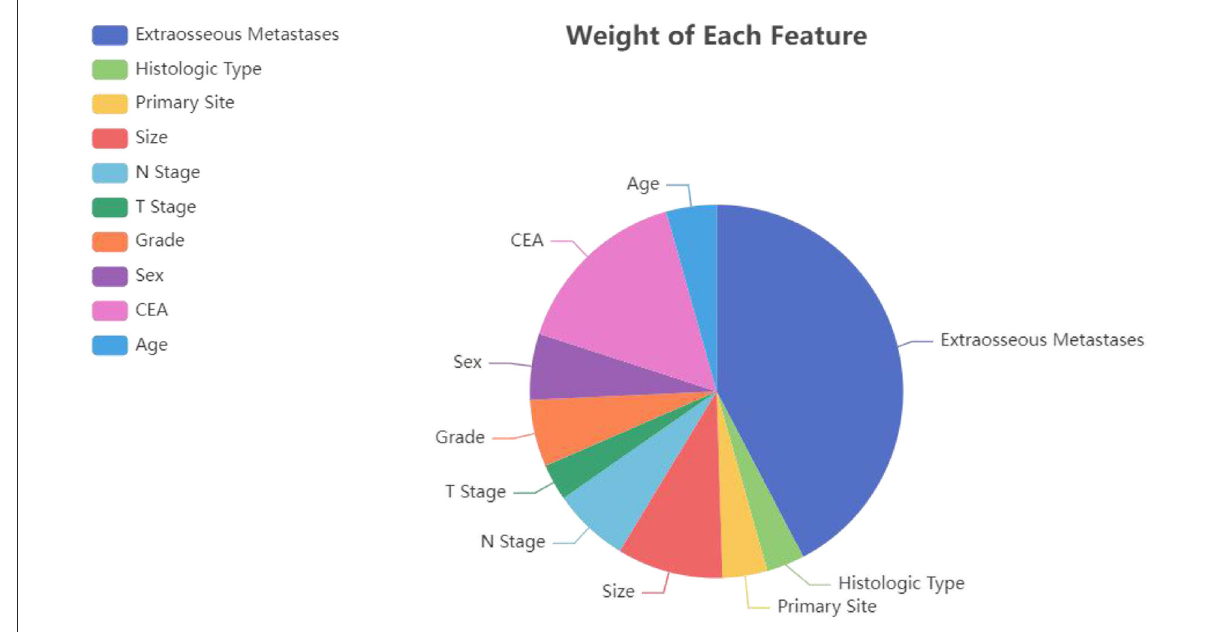
FIGURE3 The influence weight of each factor calculated by the random forest algorithm.